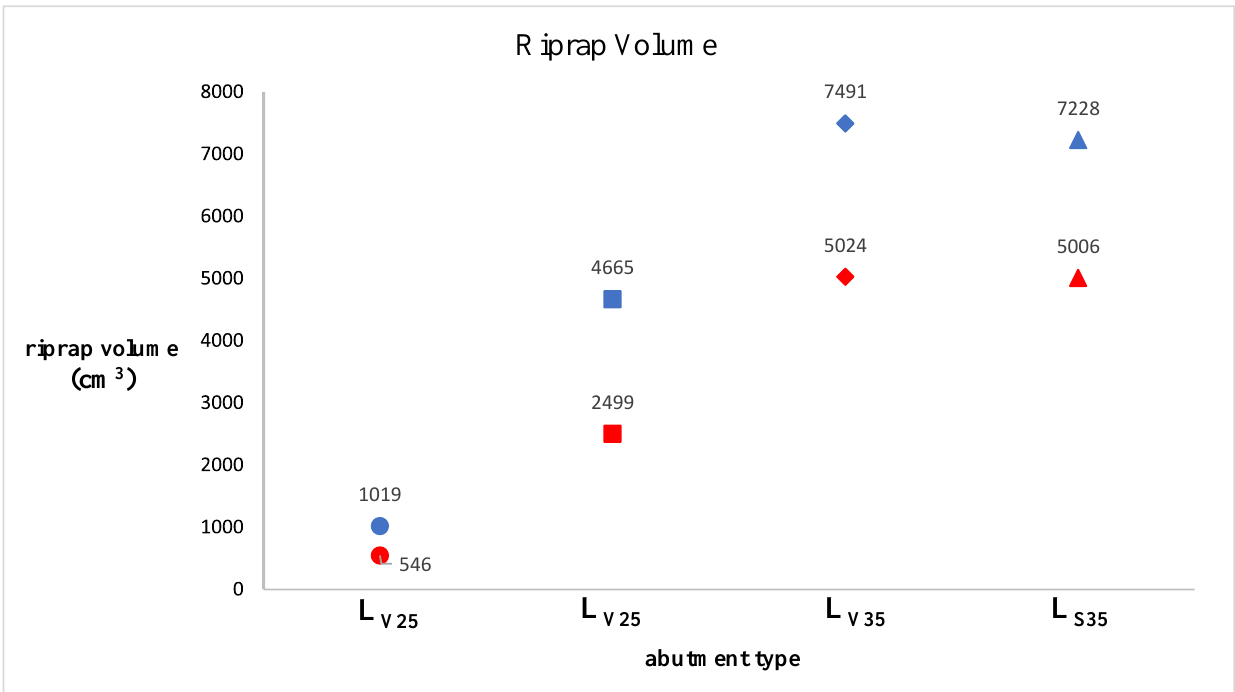
Figure 8. Volume of riprap layer around abutments. Blue symbols represent riprap with 𝑡 = 3𝐷 𝑅50 and red symbols represent 𝑡 = 1.5𝐷 𝑅50 .